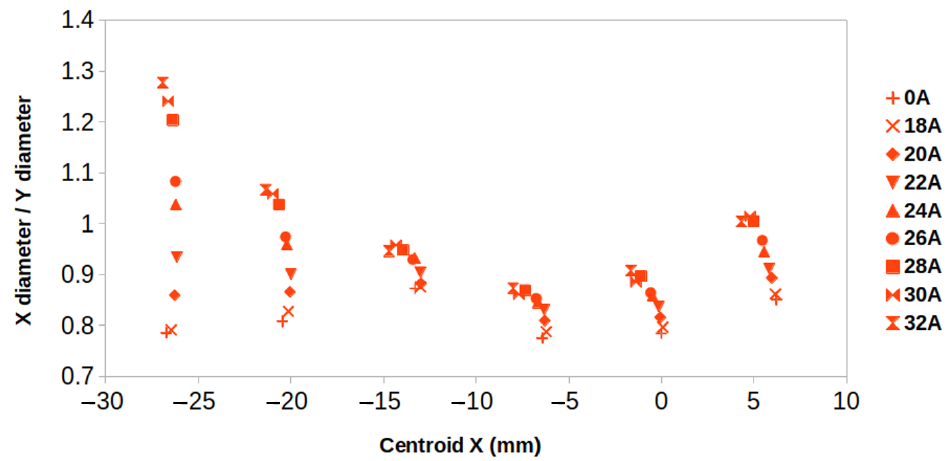
Figure 17. The ratio of the x diameter to the y diameter for beam spots in the six spot data with increasing magnetic field